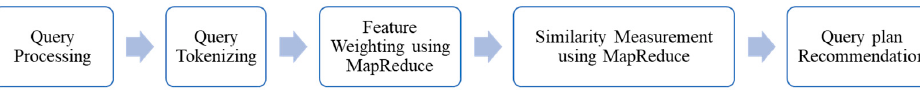
Table 1. An example of SQL query tokenization.